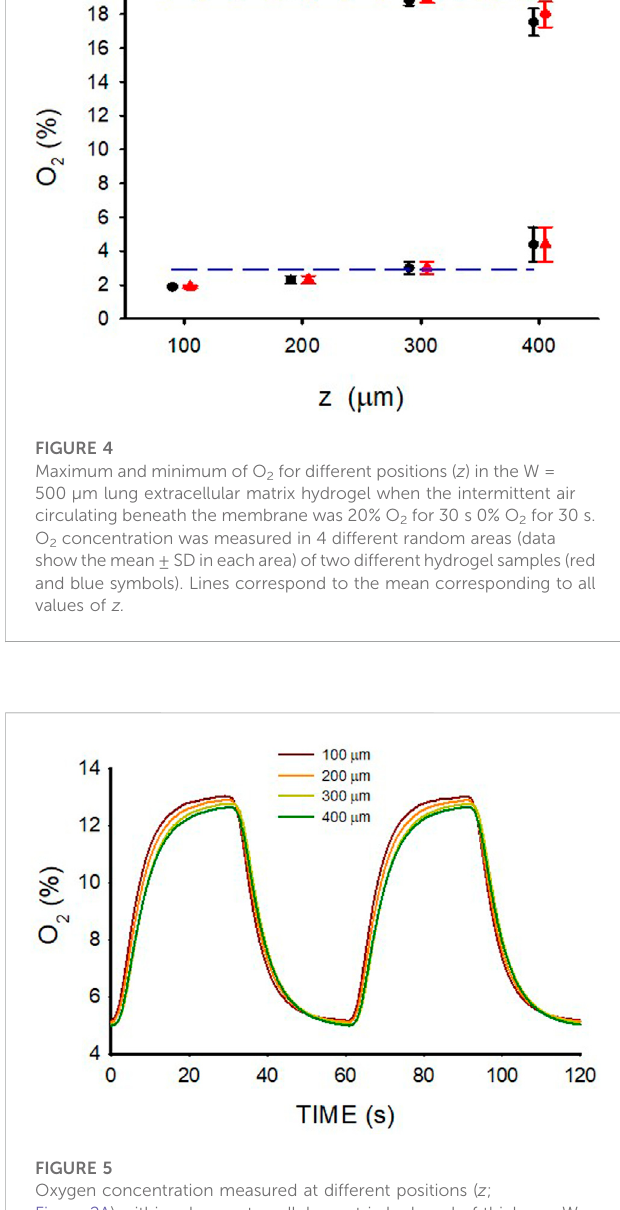
around the corresponding mean value.